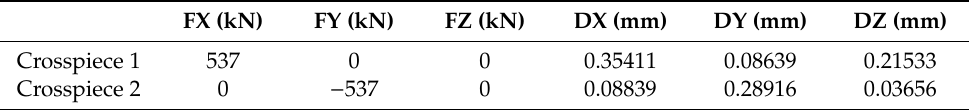
Table 8. Displacement of crosspiece if shortened by 1 mm (537